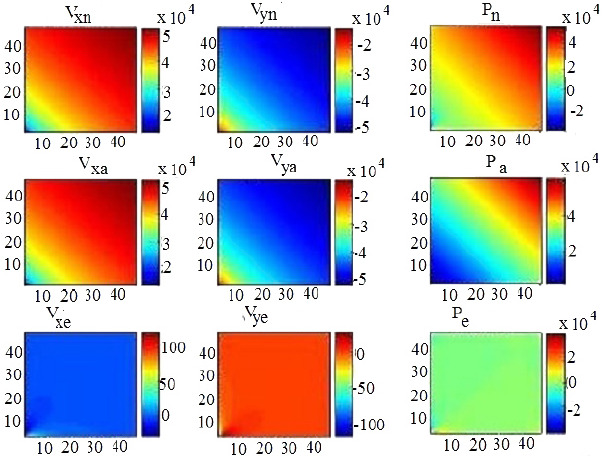
Figure 2. Distribution of v x , v y and P ; 2-D case, linearly varying viscosity, high-viscosity contrast ( η 2 = η 3 = 100), v xe = v xn − v xa , v ye = v yn − v ya , P re = P rn − P ra